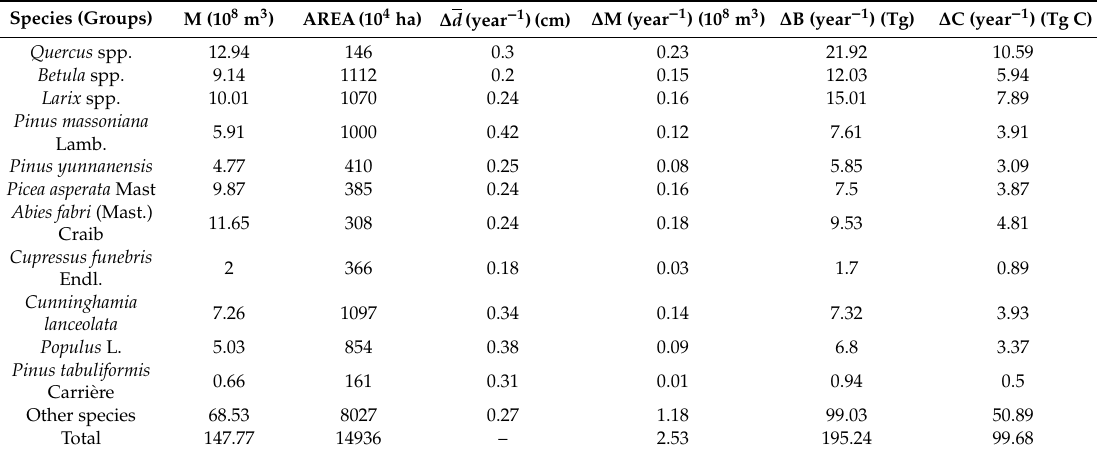
Table 7. The volume and area of Chinese forests in 2013 and the annual increases in DBH, volume, biomass, and biomass carbon stocks (BCS) in 2013–2050. Species